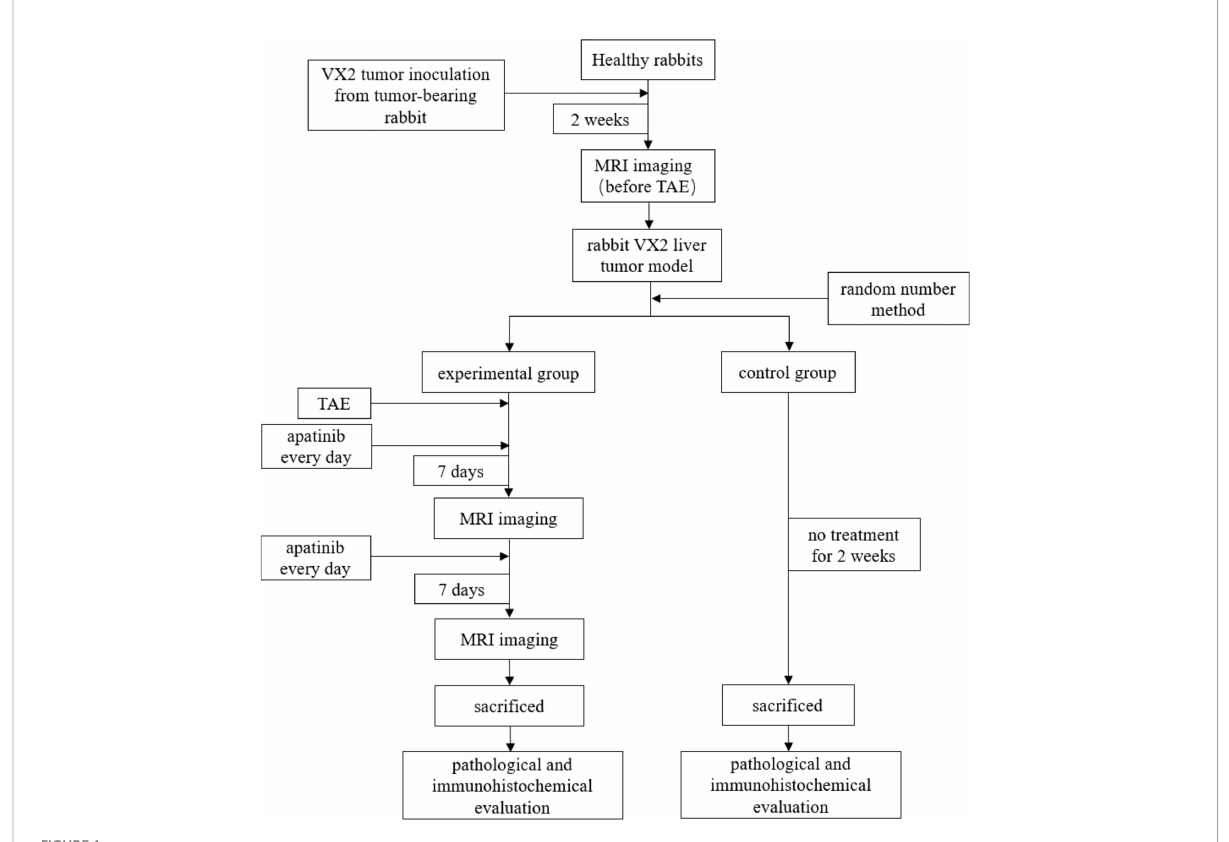
FIGURE 1 The work fl ow of this